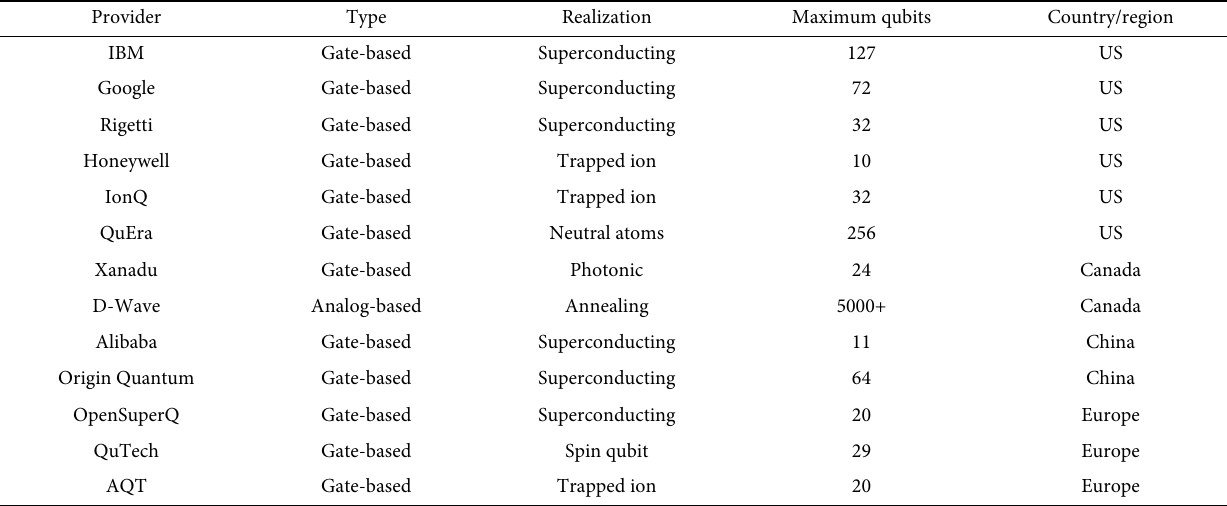
Table 1 Major providers for commercially accessible quantum computers and